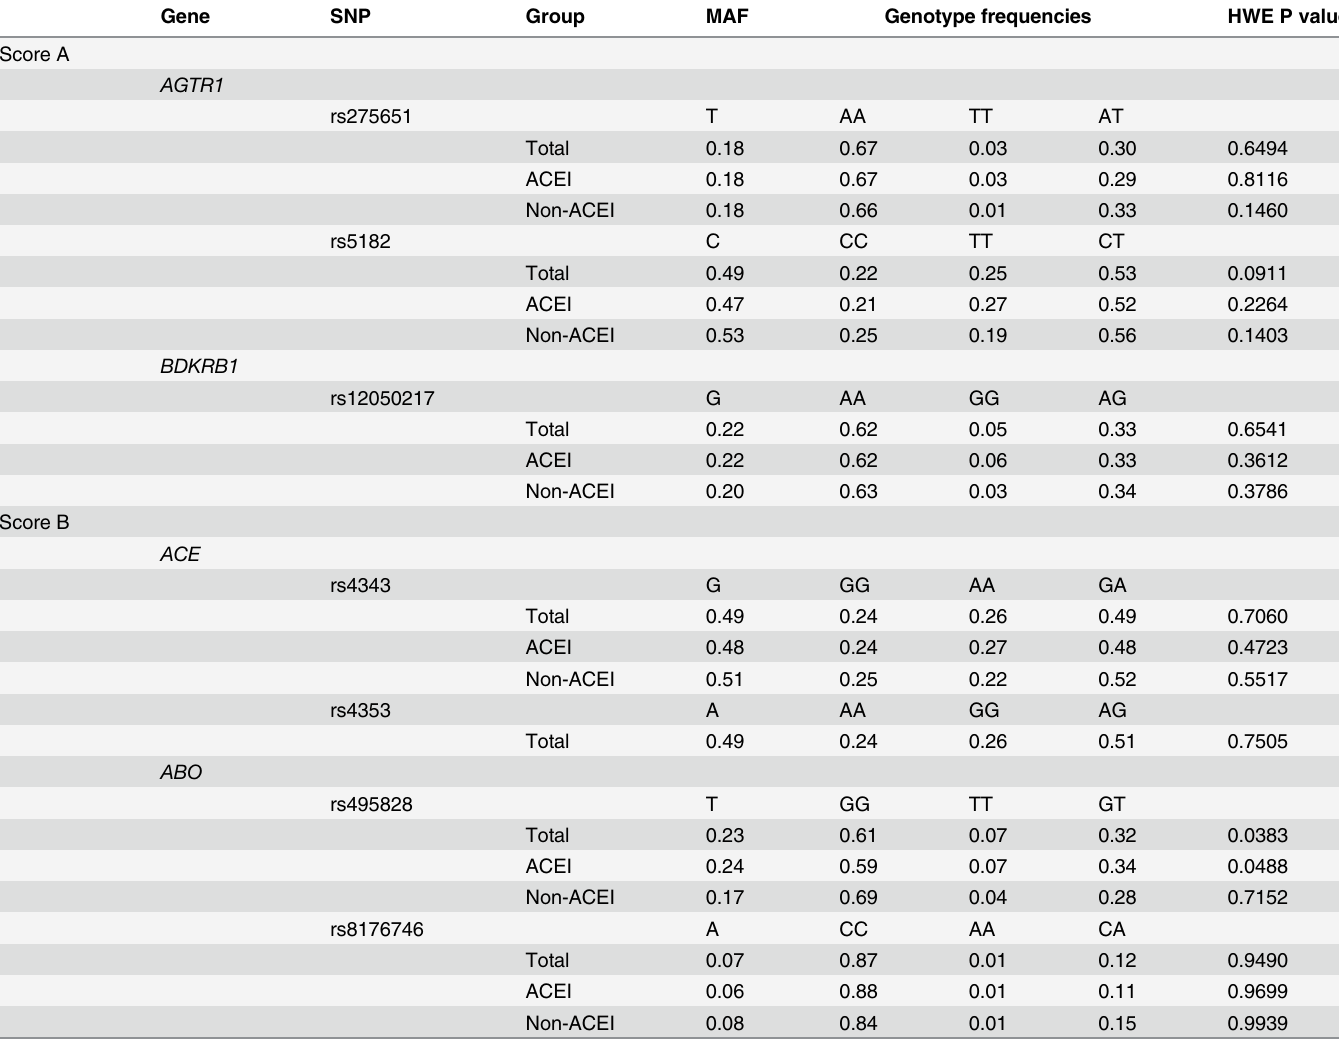
Table 3. Allele and genotype frequencies for the total study population and patients treated with and without angiotensin-converting enzyme inhibitors (ACEIs). Gene SNP Group MAF Genotype frequencies HWE P value Score A AGTR1 rs275651